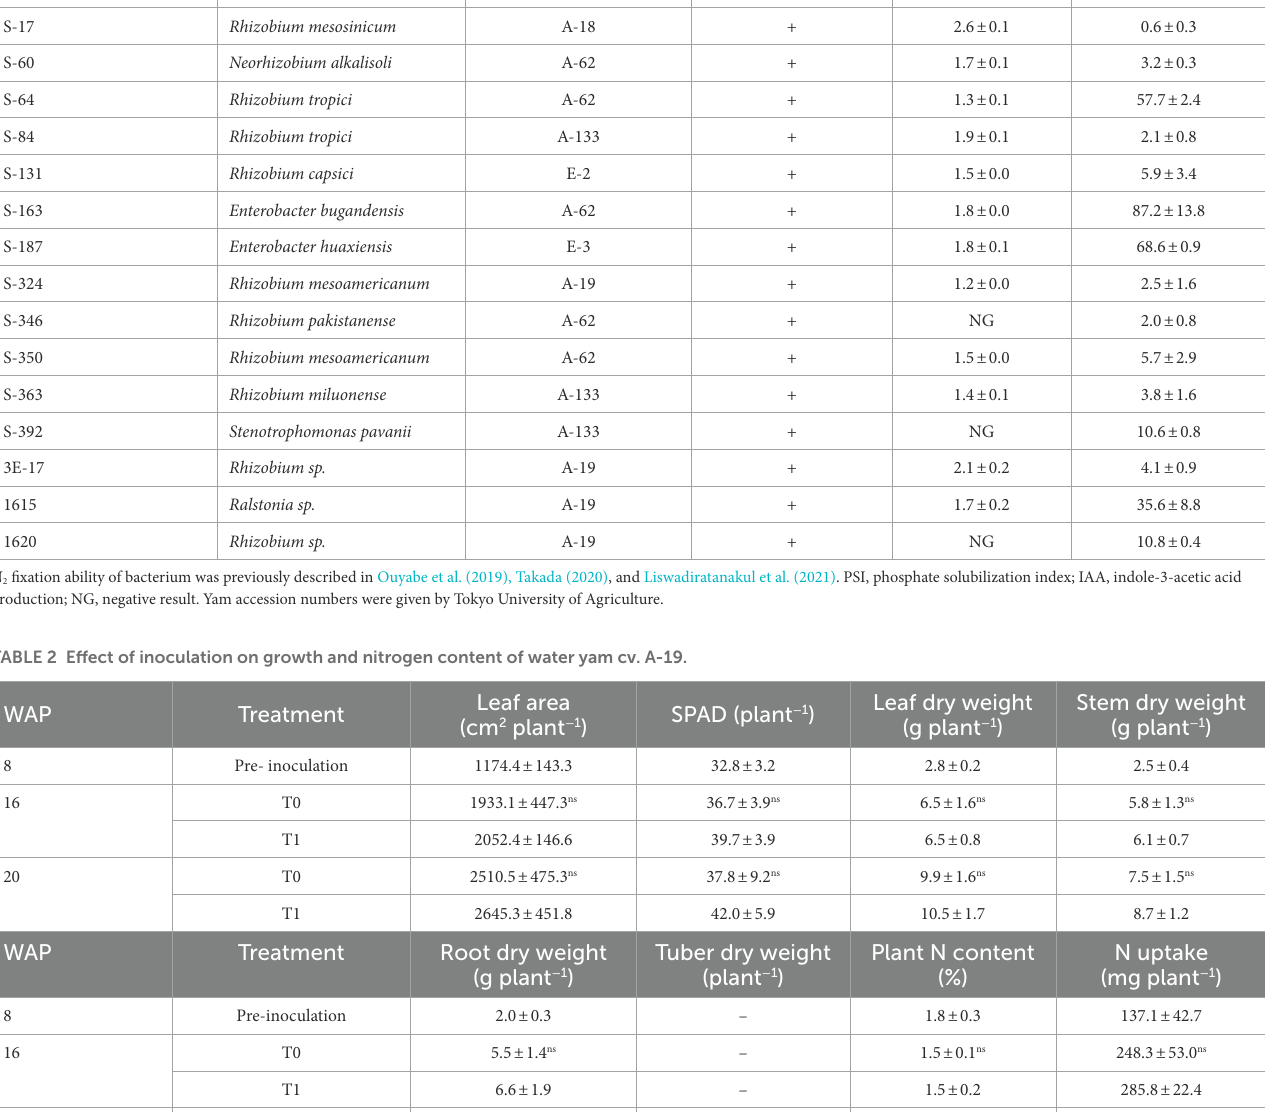
TABLE 1 Analysis of the in vitro plant growth-promoting traits of the isolated bacterial strains. Closely related Strain accession species